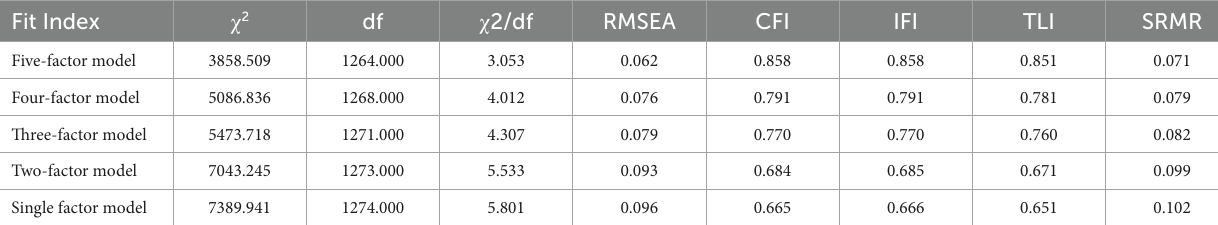
TABLE 1 Confirmatory factor analysis.